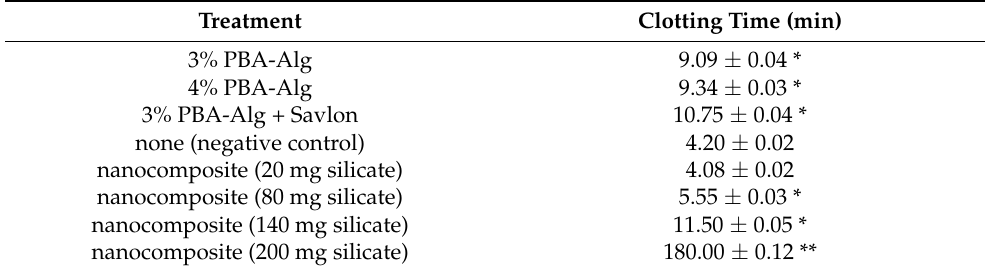
Table 1. In vitro blood clotting